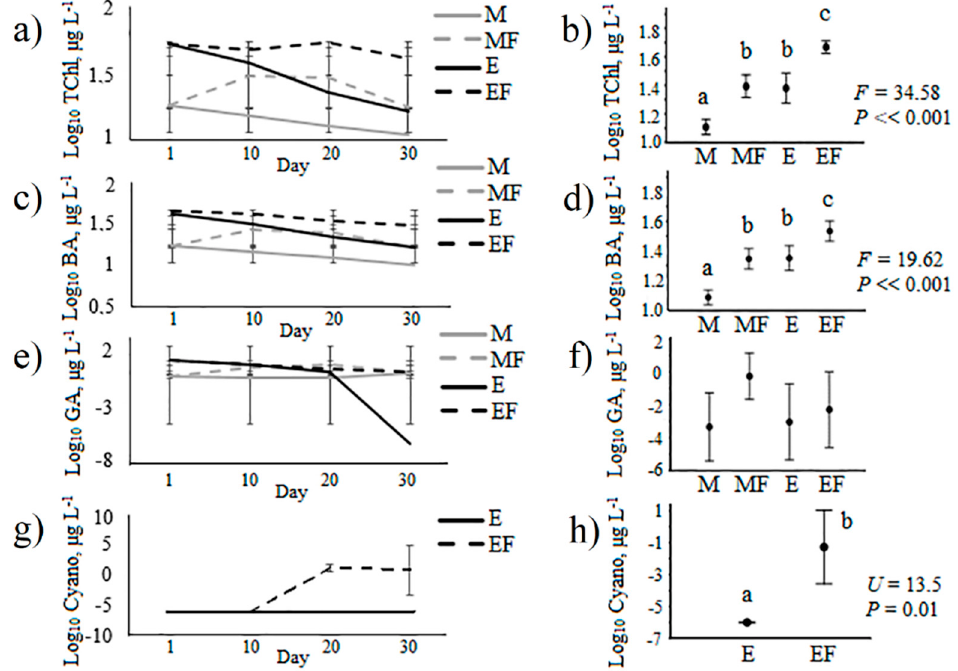
Figure3. Dynamicsofchlorophyllconcentrationsintheexperiment( a , c , e , g )andtreatmentmeans ( b , d , f , h Figure 3. Dynamics of chlorophyll concentrations in the experiment ( a , c , e , g ) and treatment means ( b , d , f , h ); different letters indicate significant differences at P < 0.05 after Fisher’s LSD post hoc test